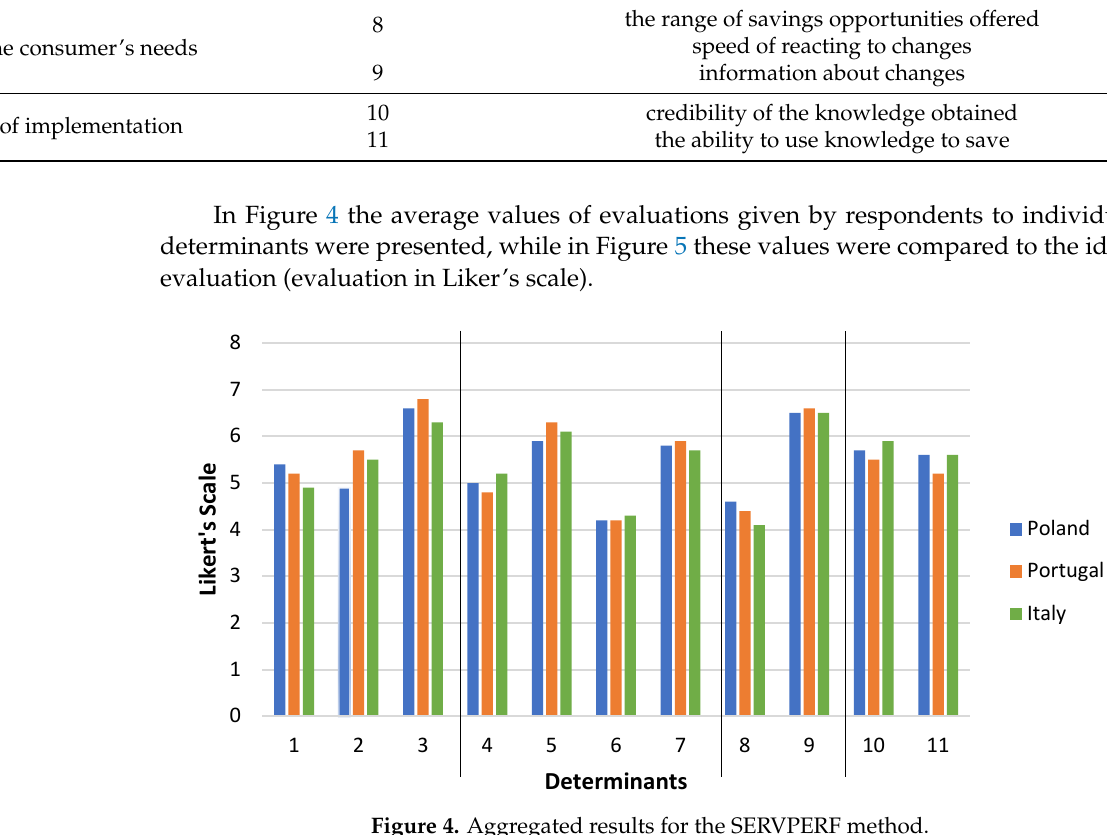
Figure 5. Percentage in relation to the Likert’s scale for the SERVPERF method. Figures 4 and 5 present the Likert scale of the respondents in each country and the assigned percentages. It is clearly visible that determinants 3, 5 and 9 were rated as the highest. While the quality of the calculation methods allows the person who plans the expenses to estimate the size of the bill, there is also certainly a noticeable desire to learn about saving methods, which causes a snowball effect, resulting in the head of the family motivating all household members to save energy. One person with an ecological attitude is enough, who cares for the functioning of the planet or simple economic savings, and the rest join it in most cases. Moreover, the speed and the ability to react to changes are equally important. The changes may include new tariffs for servicing new farms on the market, or new technological solutions allowing for energy saving. The average values of each group were shown in Figure 6.